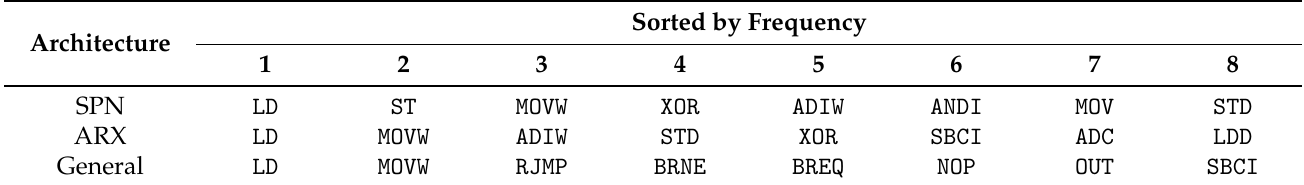
Figure 9. Visualization of opcode frequency for each algorithm. Table 6. Comparison of each architecture depending on instruction frequency.